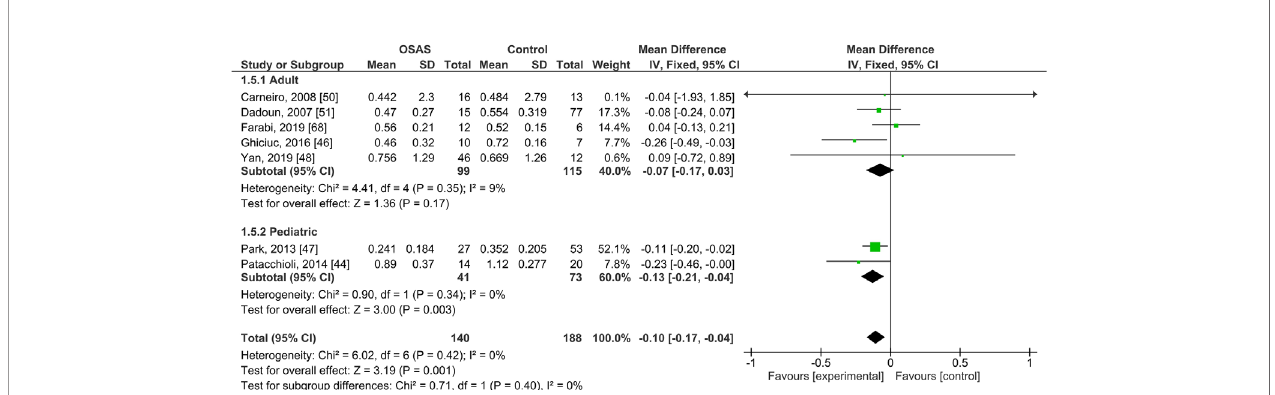
FIGURE 2 | Forest plot of random-effects analysis of salivary cortisol levels in adult and pediatric obstructive sleep apnea syndrome (OSAS) versus the control group. The diamond shape indicates the pooled mean difference (MD). Each black box represents a point estimate of each study and also gives a representation of the study size (the bigger the box, the more participants in the study). A horizontal line representing the 95% con fi dence intervals (CIs) of the study result, with each end of the line representing the boundaries of CI. SD, Standard deviation.